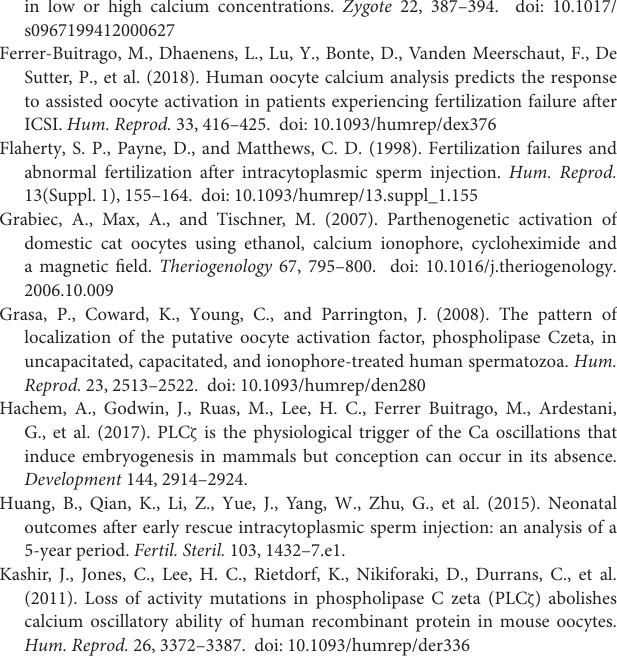
Supplementary Table 1 | Semen parameters of the participants